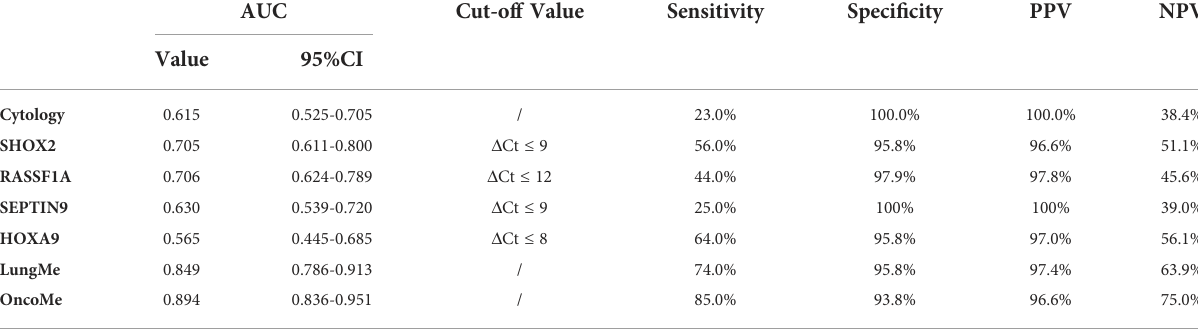
TABLE 3 The diagnostic ef fi cacy of cytology, SHOX2, RASSF1A, SEPTIN9, HOXA9 and LungMe ® 、 OncoMe methylation panel. AUC Cut-off